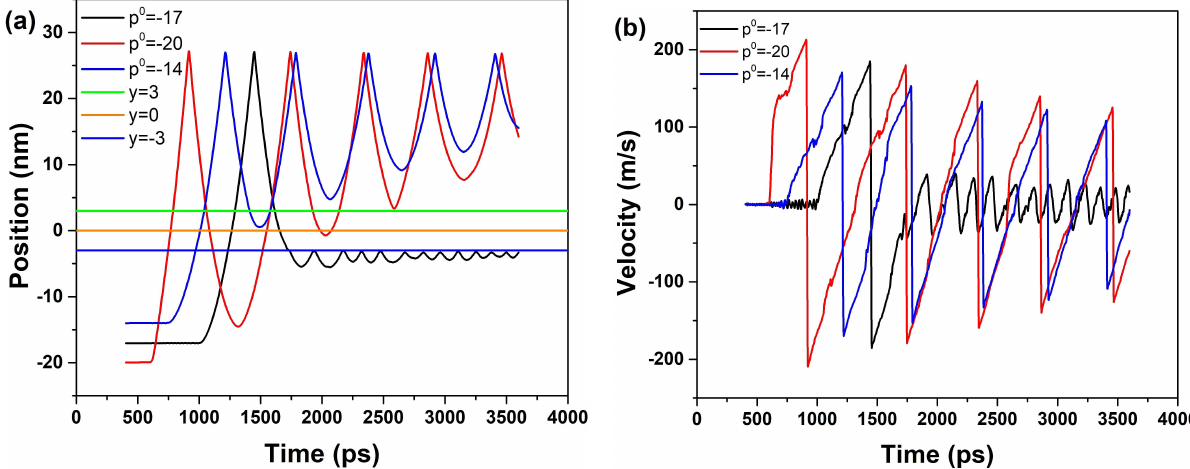
Figure 14: Variation of the movement behaviors with time for the initial position of the outer tube in system is p 0 = − 20nm, p 0 = − 14nm and p 0 = − 17nm respectively: (a) The position with time. (b) The velocity with